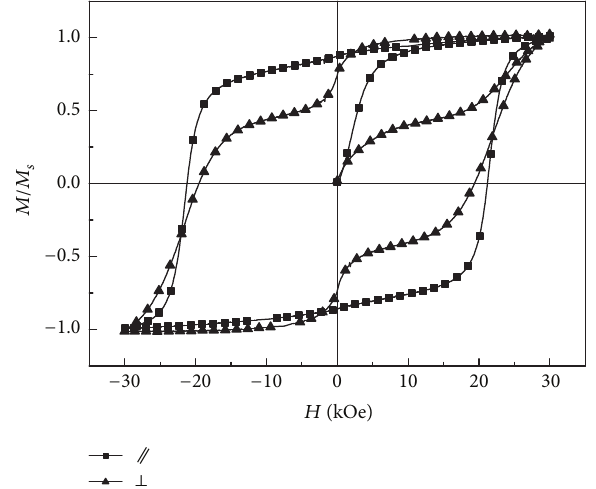
Figure 5: Hysteresis loops of Ta/Nd/NdFeB (750 nm)/Nd/Ta film.